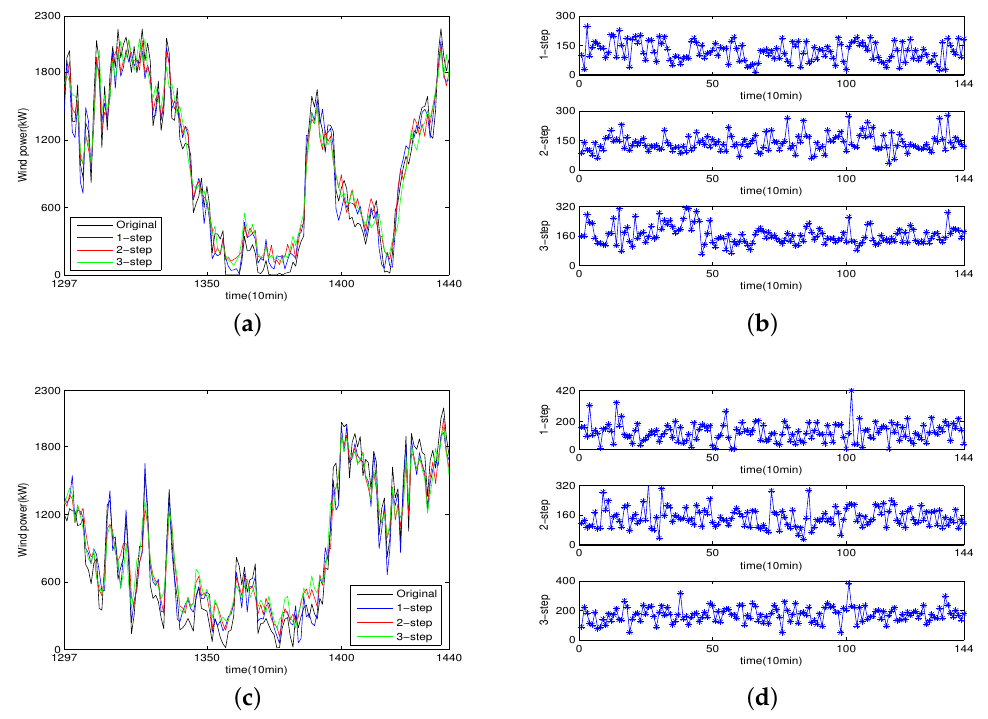
Figure 9. Forecasting results by the proposed model. ( a ) Wind power dataset A. ( b ) Forecasting absolute error for dataset A. ( c ) Wind power dataset B. ( d ) Forecasting absolute error for dataset